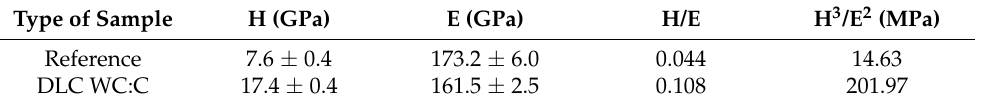
Table 2. DLC WC:C nanoindentation results for the hardness (H), Young modulus (E) and their H 3 /E 2 relationship. H 3 /E 2 relationship.